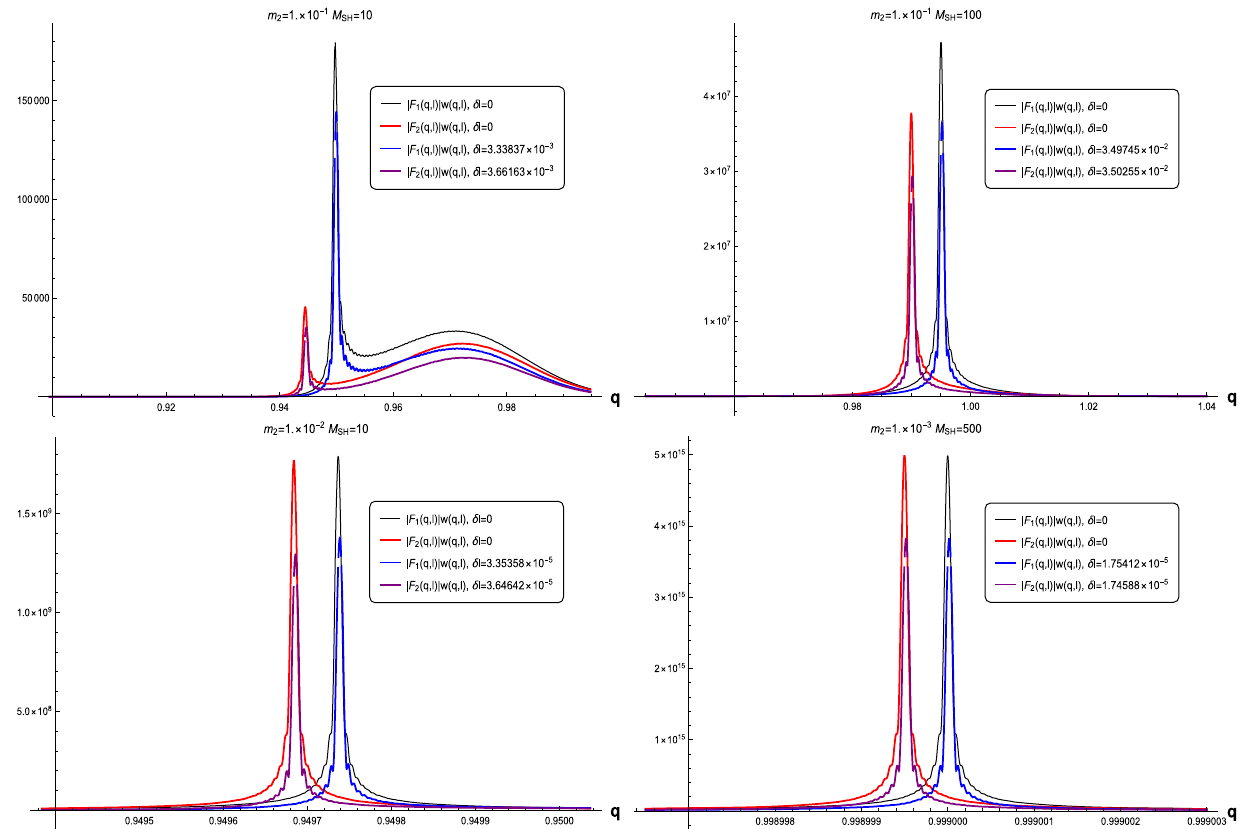
Fig. 4 As in Fig. 2, but here the wavepackets were taken into account as well ( σ d = σ s = 0 . 015). Notice that, when m 2 = 0 . 1 (top panels), the range of q considered was broader than in Fig. 2, to better show the effect of the wavepackets. In the other cases (bottom panels), the range of q is the same as in Fig.